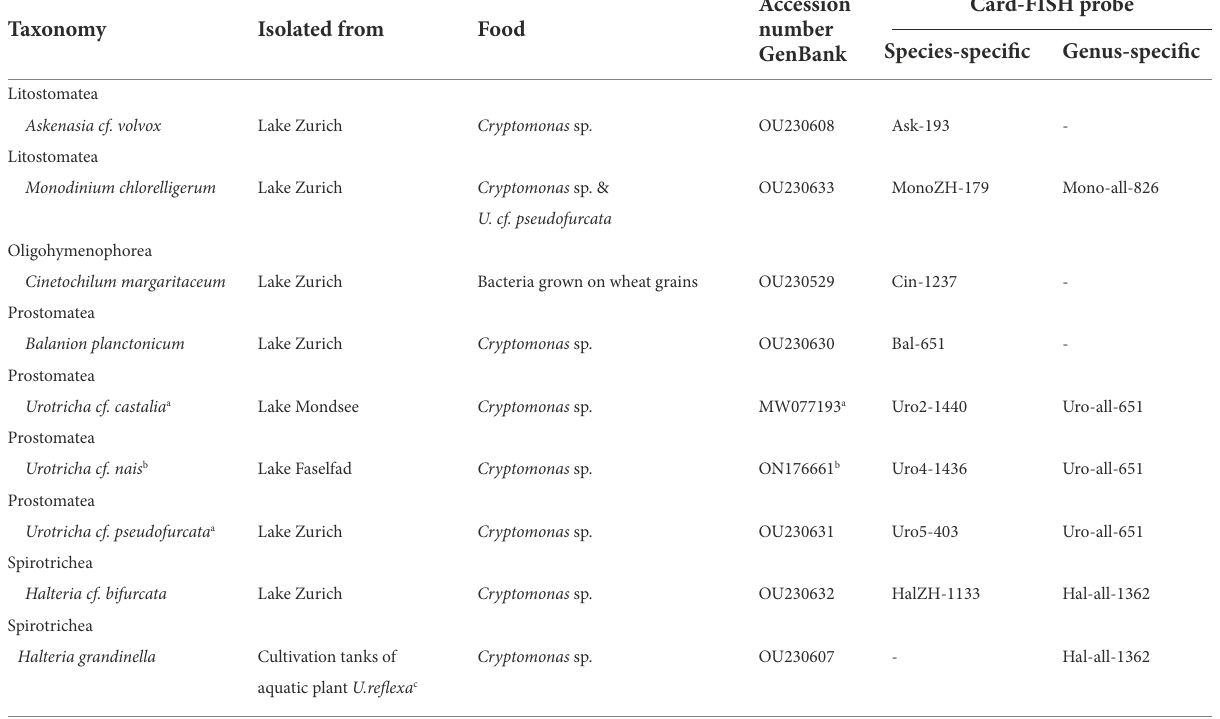
TABLE 1 Information regarding the nine examined ciliate species on which the CARD-FISH method was tested and modified. Detailed information on oligonucleotide probes can be found in Supplementary Table S2. Species where an unambiguous identification was not possible are labeled with cf. (Latin for confer/conferatur).